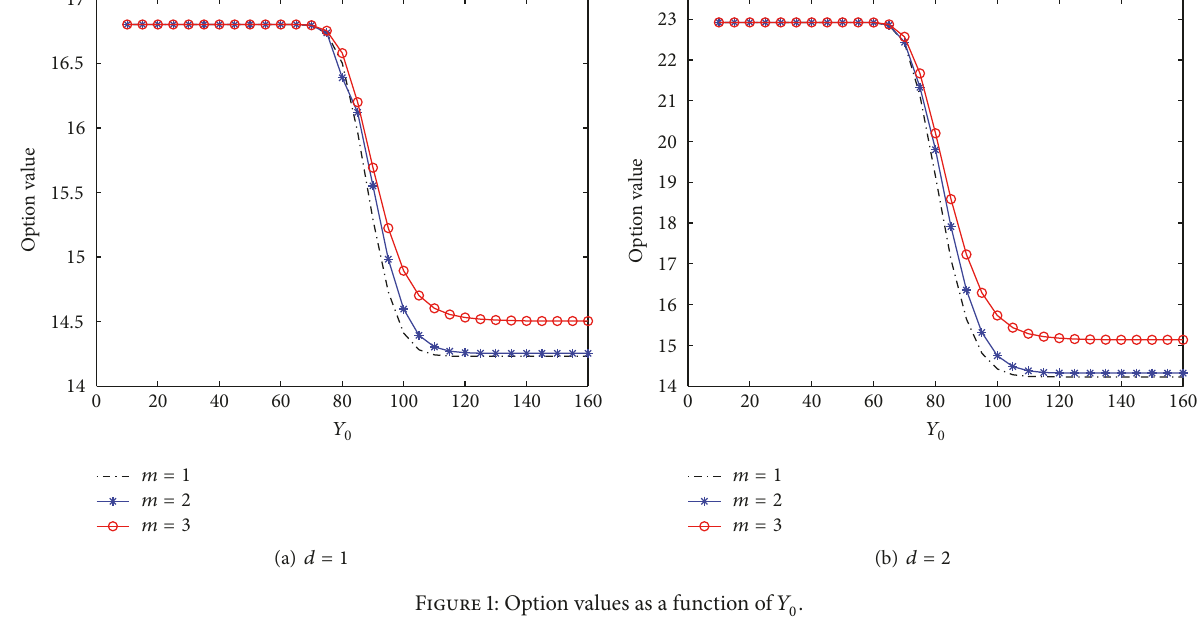
Figure 1: Option values as a function of 𝑌 0 .